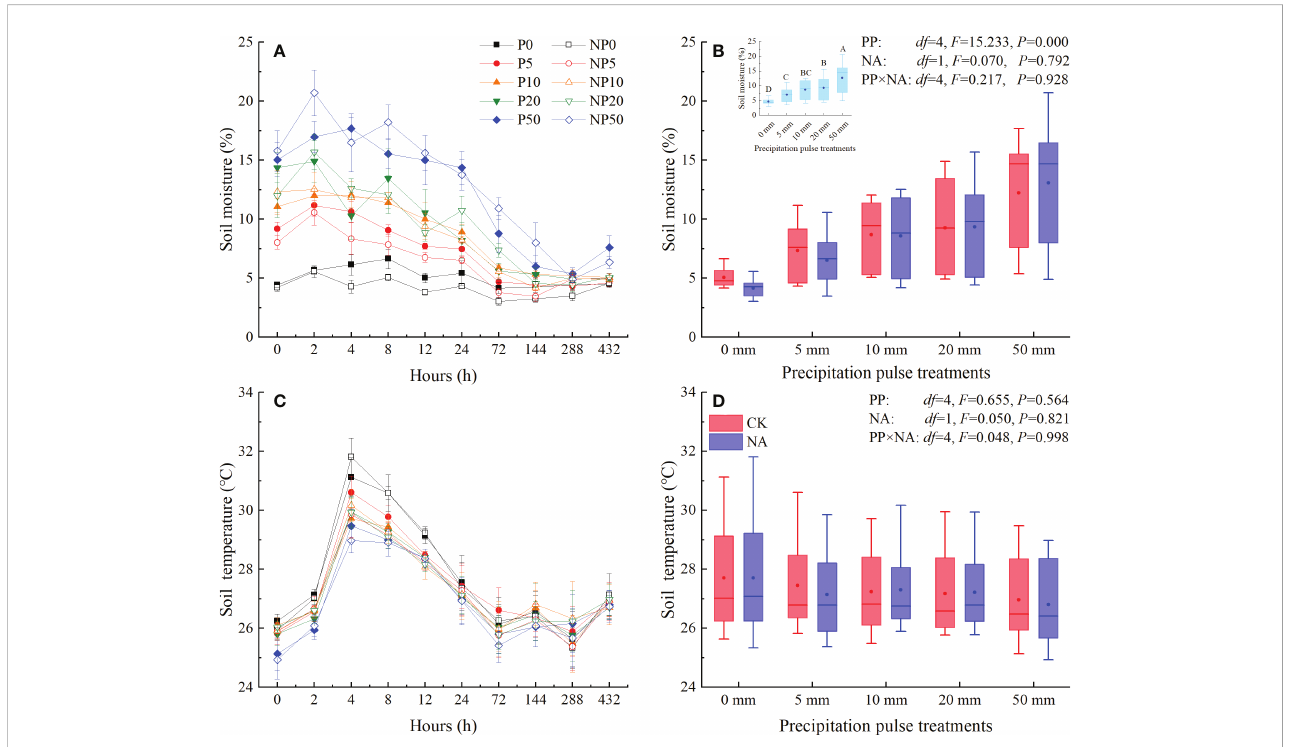
FIGURE 1 Responses of soil moisture at 0-10 cm depth ( (A) : temporal dynamic; (B) : average soil moisture) and soil temperature at 5 cm depth ( (C) : temporal dynamic; (D) ) average soil temperature) to precipitation pulses and N addition treatments. The inserted graph in panel B (light blue column) shows the differences in average soil moisture among the precipitation pulses. Boxplots show the median (lines within the box) and interquartile range (box boundaries). Whiskers extend to the most extreme data point within 1.5 × (75-25%) data range. The solid point represents the mean value. Different capital letters (above each boxplot) denote signi fi cant differences among the precipitation